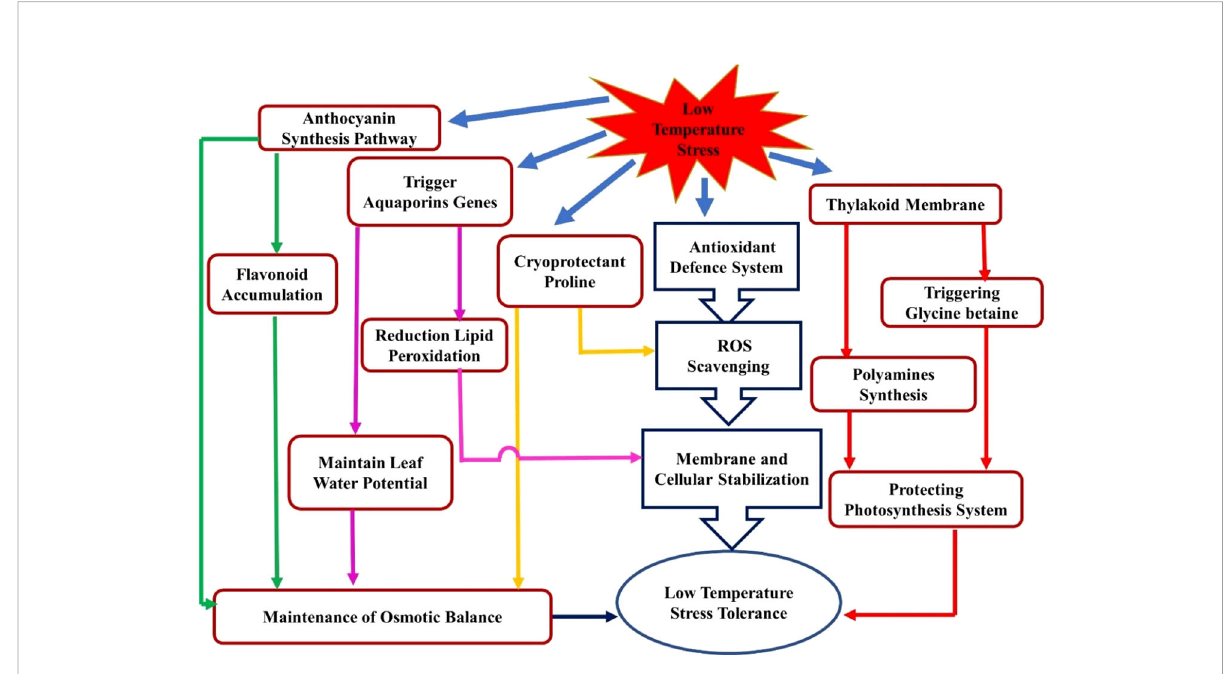
FIGURE 2 Systematic representation of stress responses and stress regulator crosstalk for low-temperature tolerance in